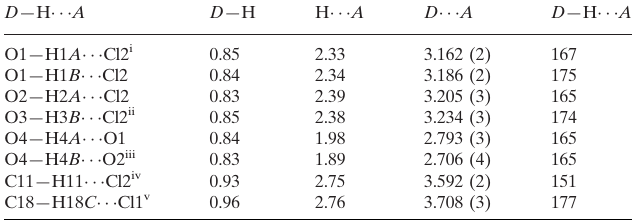
Hydrogen-bond geometry (A˚ , (cid:4)